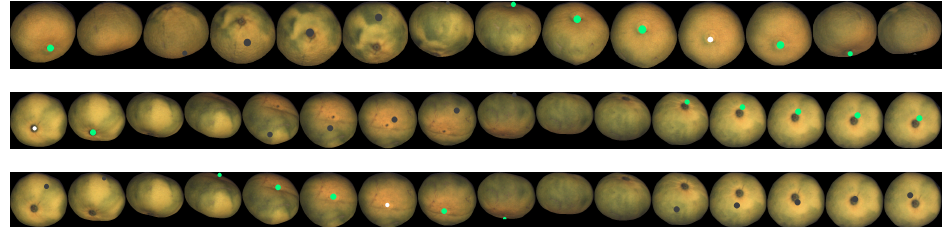
Figure 26. Example of point tracking in the case of two different oranges. The geometry model in this case is sphere. The sequence has been truncated to the views where the tracked point remains visible.